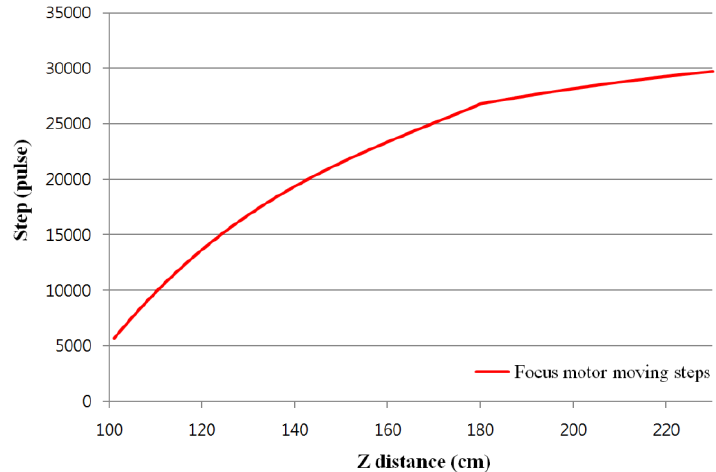
Figure 5. Step increments of motor for auto-focusing according to Z